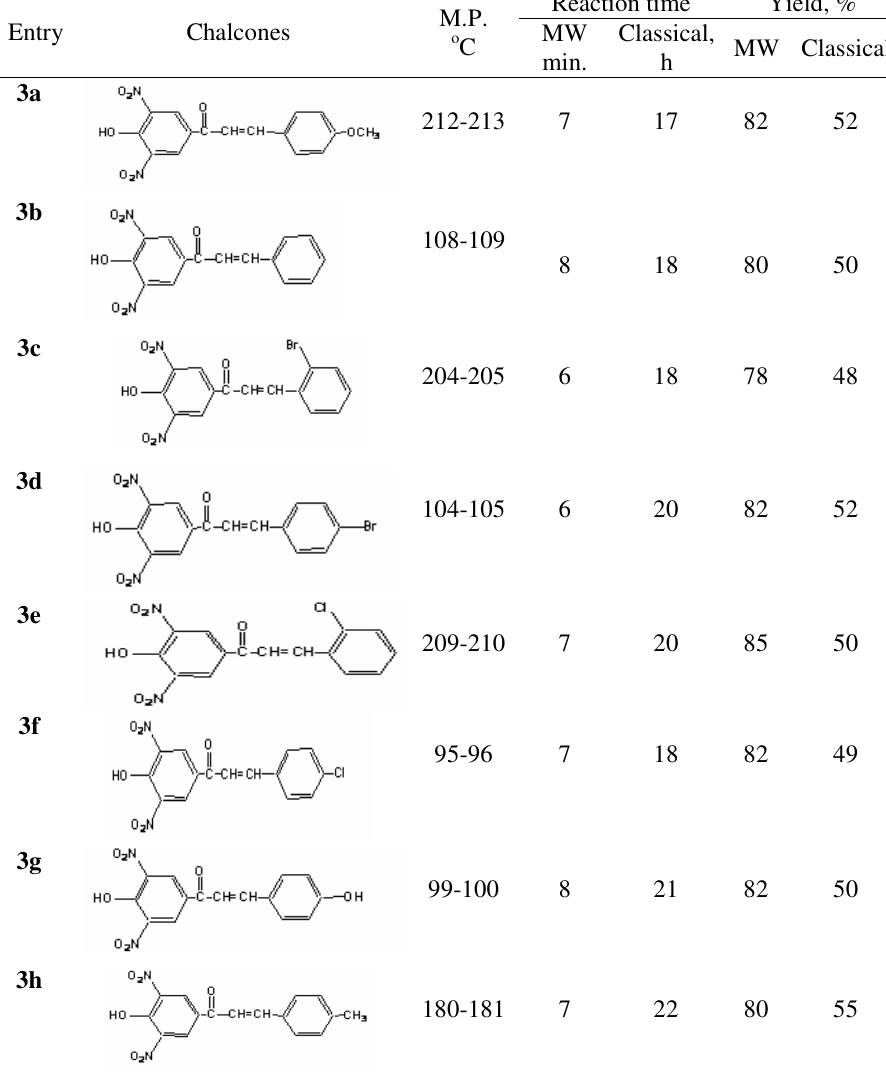
Reaction time Yield, %